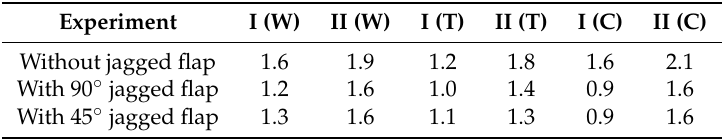
Figure 4. IL 2 gained by the plenum window with perforated thin box (compared with the case of without thin box) for experiments I and II. ( a ) White noise ( b ) traffic noise ( c ) construction noise. Results are presented using one third octave frequency band in log scale. Table 4. ∆ LA eq 2 ( dBA) for experiments I and II when frequencies are ranging from 800 Hz to 1250 Hz. W, T and C represent white, traffic and construction noises, respectively.Results are computed using narrow frequency band with step of 2